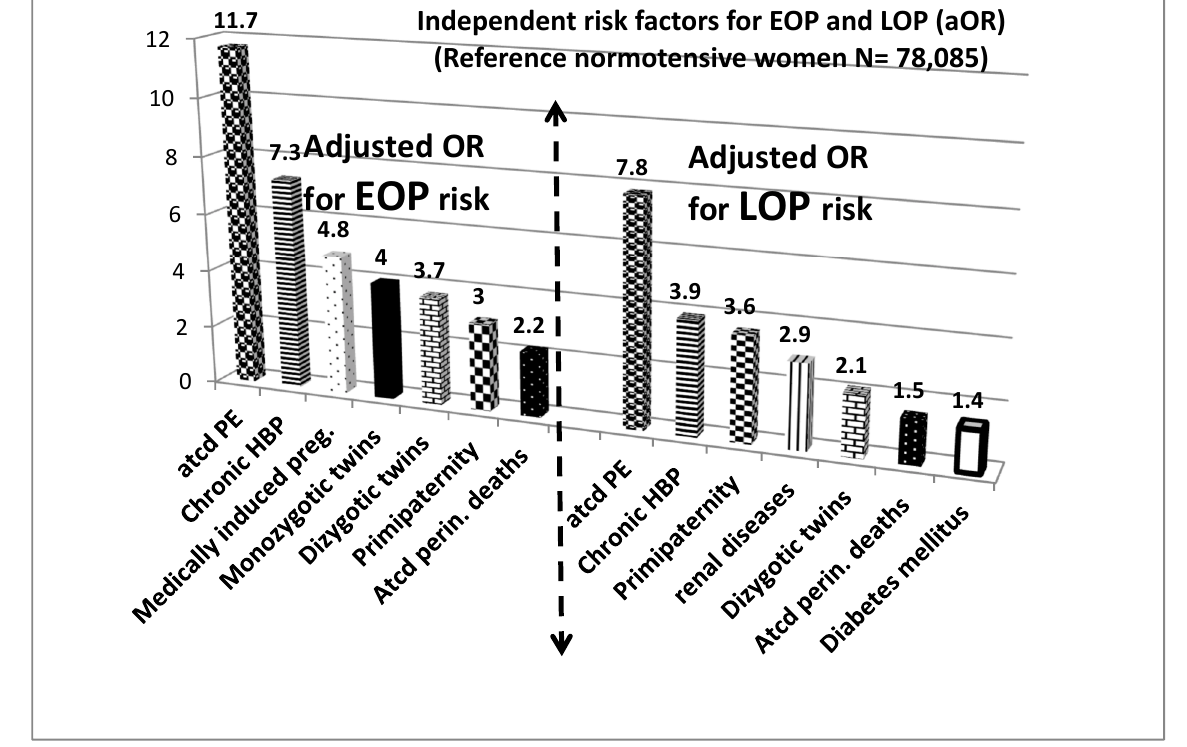
Figure 1. Independent risk factors for EOP and LOP (adjusted odds ratios) controlling for the two major confounders: maternal ages (both risks for EOP and LOP) and maternal pre-pregnancy BMI (major risk factor for LOP). Increment by 5 years of age and by 5 kg/m 2 for and maternal pre-pregnancy BMI.